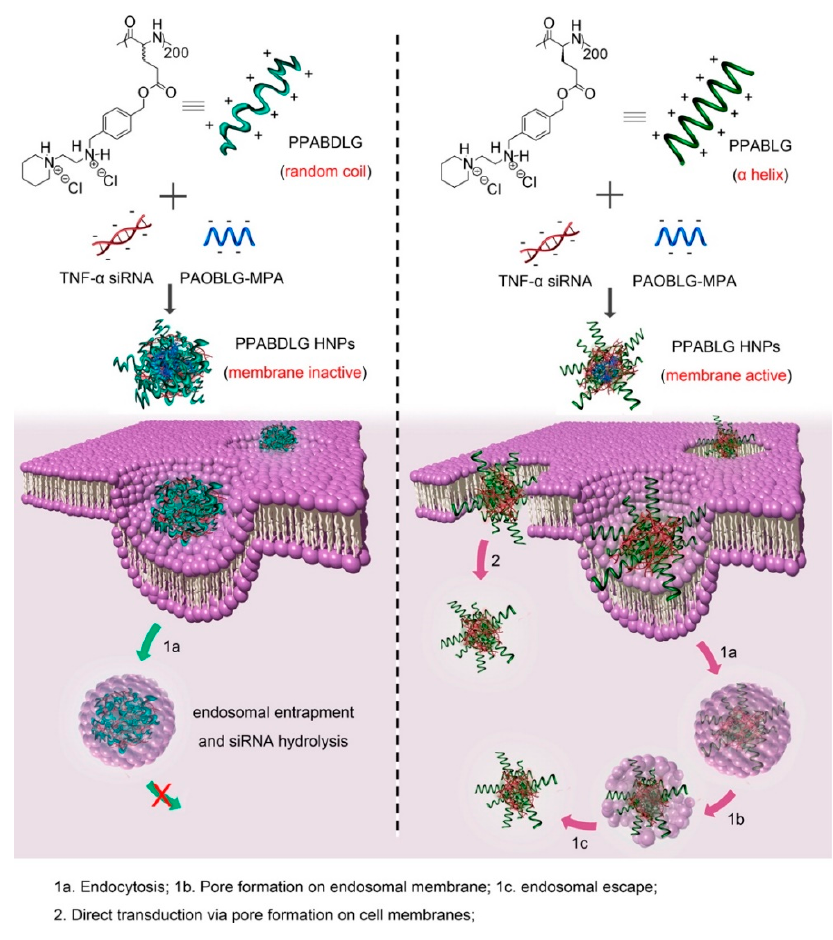
Figure 12. Schematic illustration of intracellular kinetics of PPABLG/PAOBLG-MPA/siRNA and PPABDLG/PAOBLG-MPA/siRNA showing PPABLG-helicity-dependent membrane disruption toward effective cellular internalization as well as endosomal escape. Adapted from [156], with permission. Copyright: 2016 American Chemical Society.